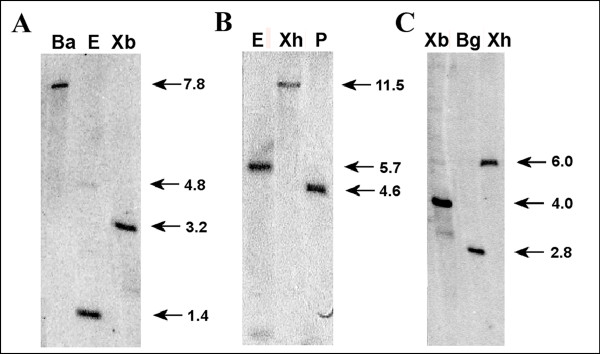
Southern blot analysis of 5 μg genomic DNA isolated from the hop cv. Osvald's clone 72. The blot was hybridized with a 32P-labeled cDNA fragment. (A) HlWDR1 gene: BamHI (Ba) and XbaI (Xb) do not cut within the HlWD40 gene, EcoRI (E) has one restriction site 146 bp from the 5'end of the cDNA. (B) HlbHLH2 gene: EcoRI (E), XhoI (Xh) and PstI (P) do not cut within the HlbHLH2 gene. (C) HlMyb2 gene: XbaI (Xb) does not cut in the HlMyb2 gene, BglII (Bg) and XhoI (Xh) have one restriction size, but only 69 resp. 43 bp from the 3'end of the cDNA. The arrows show the position of the restriction fragment hybridizing with the cDNA probe fragment. The estimated size is indicated in kilobases (kb).